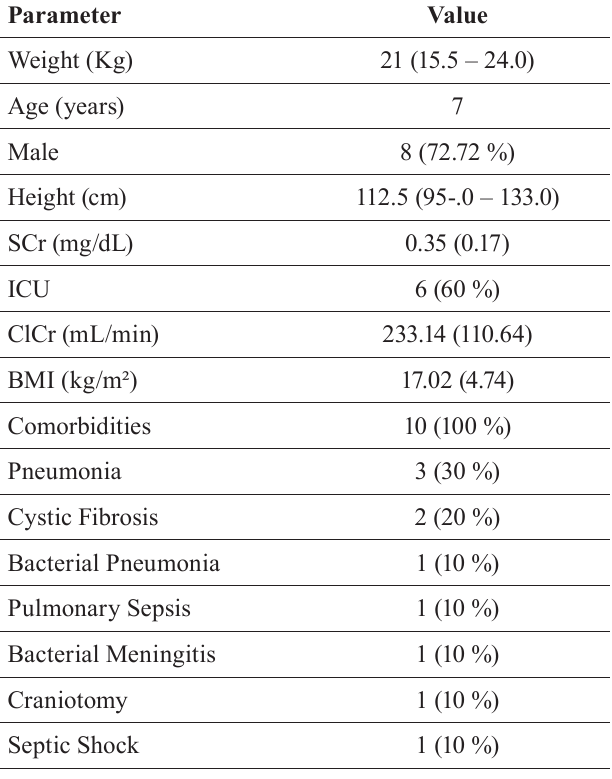
TABLE I - D emographic and clinical